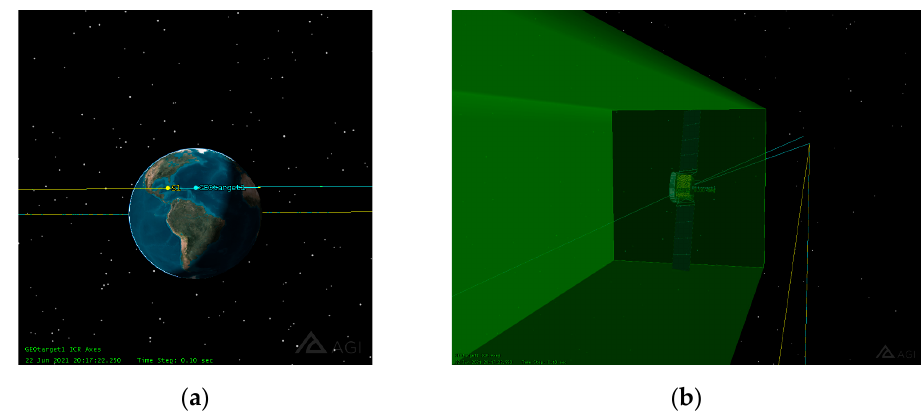
Figure 3. Simulation in the STK: ( a ) Earth synchronous orbit (GEO); ( b ) camera’s field of view.